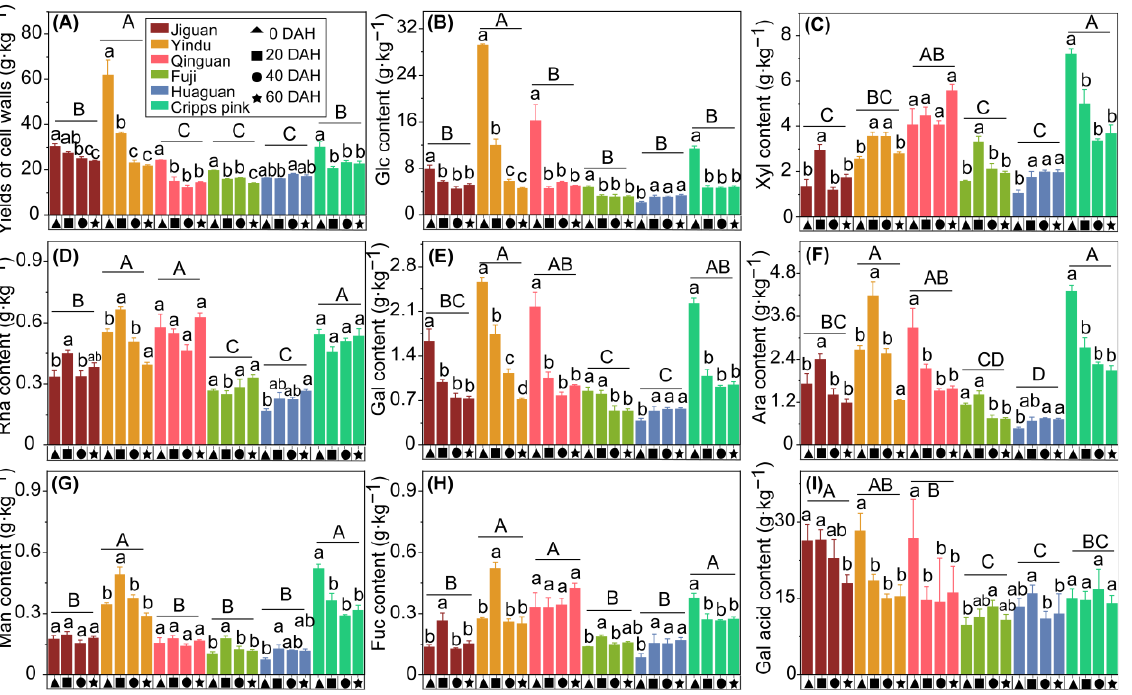
Figure 4. Cell walls material (CWM) yields and its neutral sugar compositions content of ‘Jiguan’, ‘Yindu’, ‘Qinguan’, ‘Fuji’, ‘Huaguan’ , and ‘Cripps pink’ apple fruit s stored at 25 ± 1 °C for 60 d. ( A ) Yields of CWM; ( B ) glucose (Glc); ( C ) xylose (Xyl); ( D ) rhamnose (Rha); ( E ) galactose (Gal); ( F ) arabinose (Ara); ( G ) mannose (Man); ( H ) fucose (Fuc); and ( I ) galacturonic acid (Gal acid). Data are presented as mean ± standard error (SE) from three biological replicate assays. In each plot, the capital letters above the symbols indicate significant differences ( p < 0.05) between six cultivars, and the lowercases indicate significant differences ( p < 0.05) between different stored times at each apple cultivar.